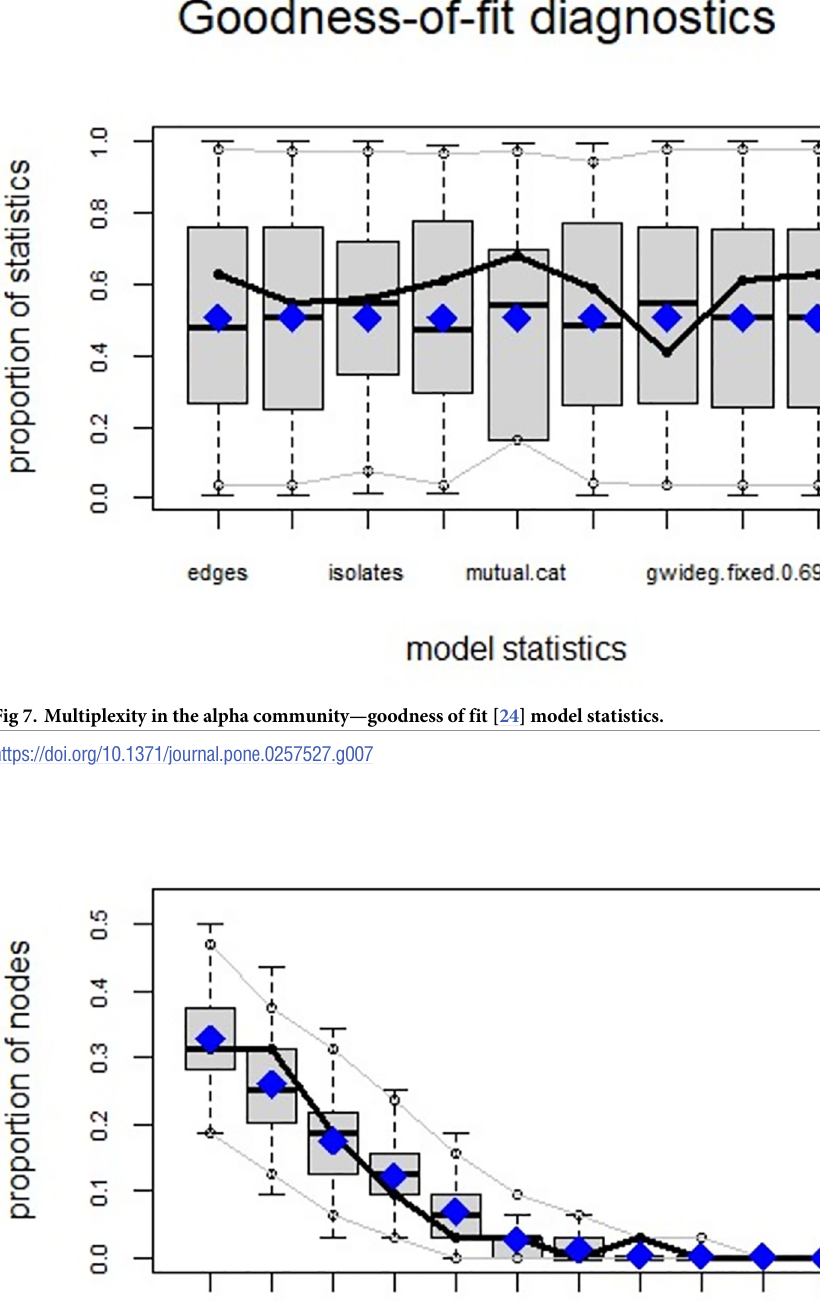
PLOS ONE | https://doi.org/10.1371/journal.pone.0257527 September 27,